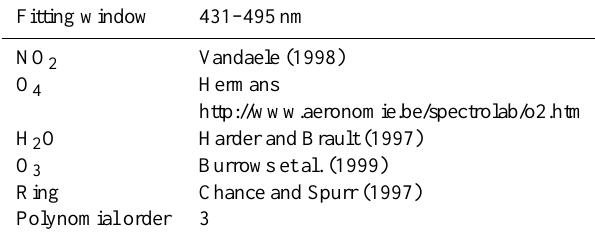
Table 1. DOAS analysis settings.